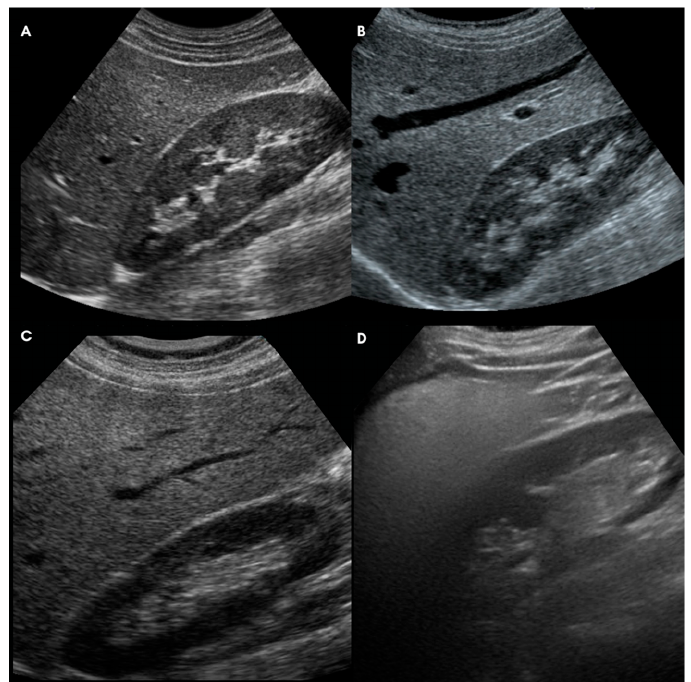
Figure 1. Ultrasound grading of hepatic steatosis: ( A ) Normal Liver (score 0); ( B ) Mild Steatosis (score 1–4); ( C ) Moderate Steatosis (score 5–8); ( D ) Severe Steatosis (score 9–12).